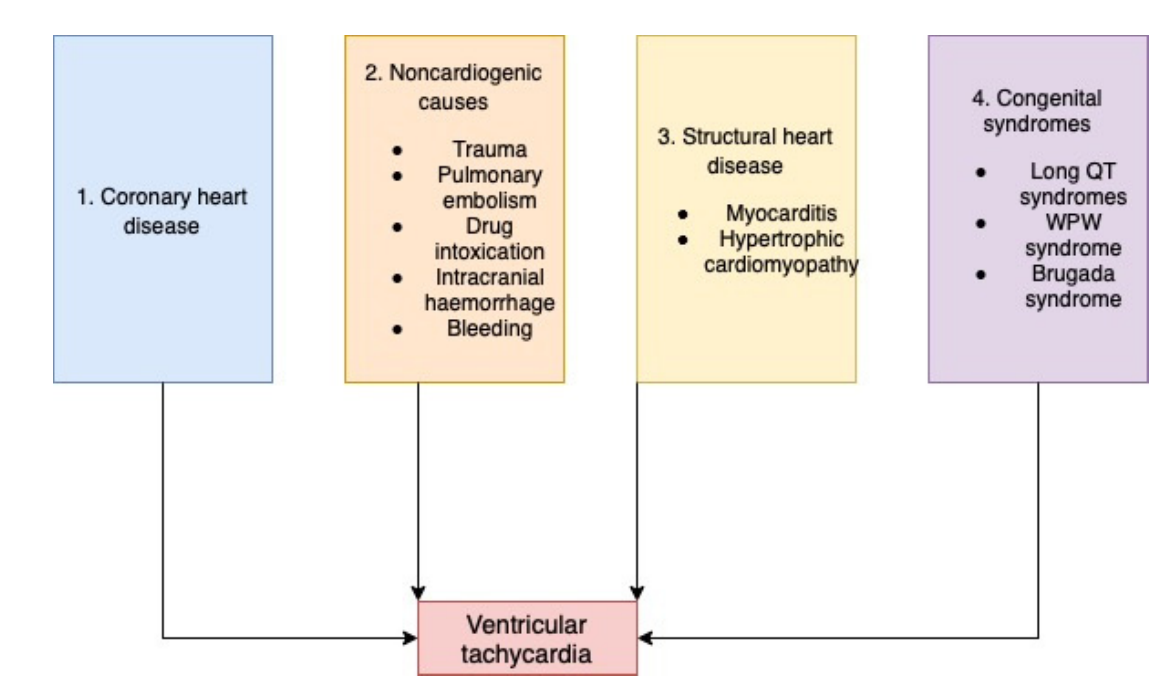
Figure 4. Etiology of ventricular tachycardia.